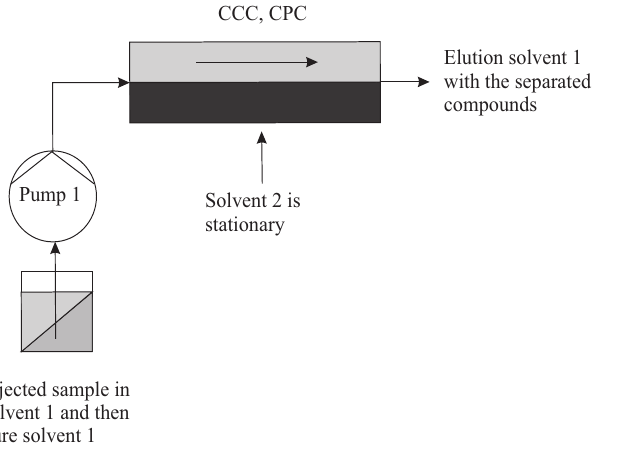
Figure 5. Simple topology of batch mode. Solvent 1 is the MP, solvent 2 is the